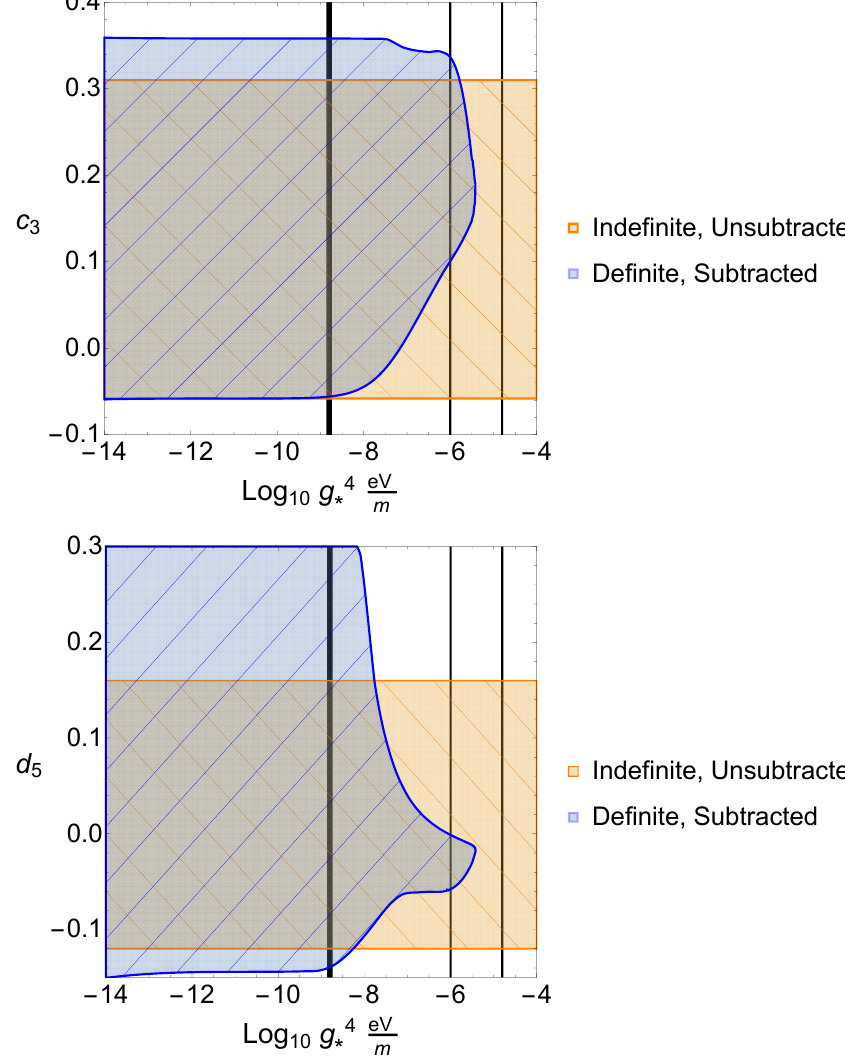
Figure 1 . Regions allowed in the f c 3 ; d 5 g parameter space of massive gravity. Those determined by subtracted bounds from de(cid:12)nite SVT scattering (as in [24]) are provided in blue, and the unsubtracted bounds from inde(cid:12)nite scattering (as in [25]) are provided in orange. The (cid:12)gure over c 3 has been maximised over the allowed values of d 5 and vice versa. The vertical lines correspond to couplings of g (cid:3) = 2 (cid:2) 10 (cid:0) 10 (in bold), and 2 (cid:2) 10 (cid:0) 9 , 10 (cid:0) 9 (thin lines) with a mass of m = 10 (cid:0) 30 eV. Ref. [24] focused on the two last values of g (cid:3) (thin lines), which have no particular physical meaning. . 10 (cid:0) 8 : 8 ( m= eV), subtracting part of the As is transparent from the (cid:12)gure, for small couplings, g 4 (cid:3) cut from SVT amplitudes does not improve on existing